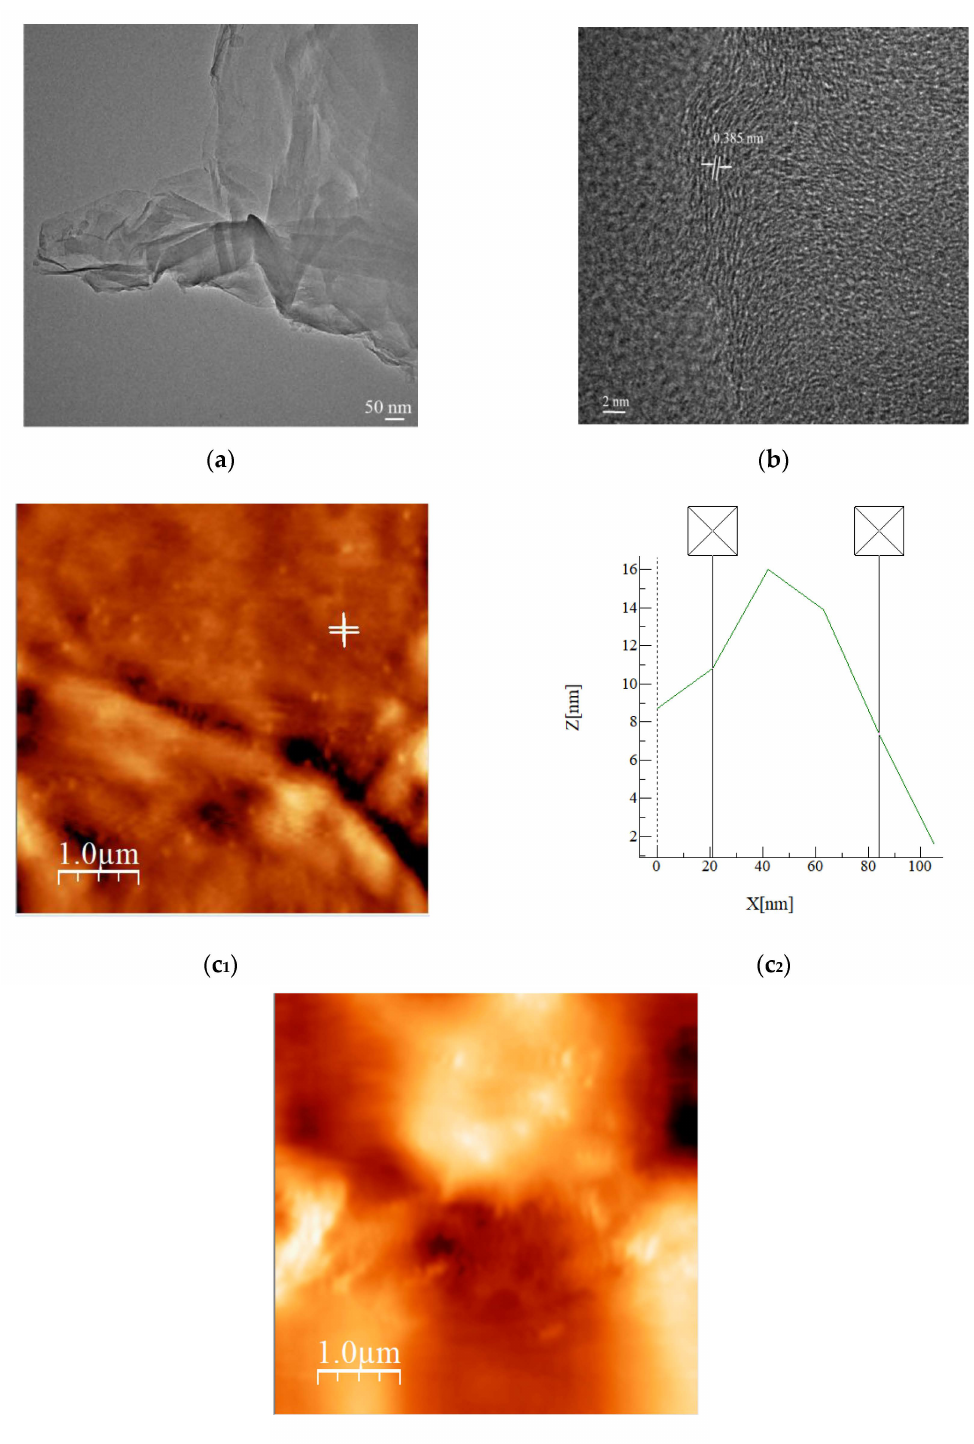
Figure 11. TEM ( a ) and HRTEM ( b ) images of the RGO sheets. The AFM image of the metallic film prepared from Au nanoparticles’ colloidal solutions with a size of 50 nm before ( c 1 , c 2 ) and after the deposition of the RGO sheets ( d